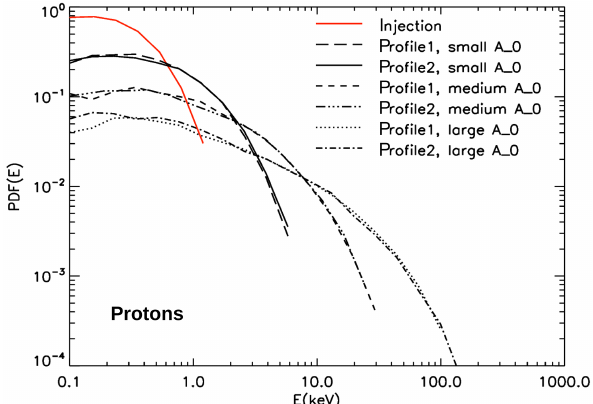
Figure 4. Comparison among the PDFs of energies of protons in the presence of profile 1 and profile 2, by varying A 0 /(cid:96) = 10nT (large A 0 ), A 0 /(cid:96) = 3nT (medium A 0 ) and A 0 /(cid:96) = 1nT (small A 0